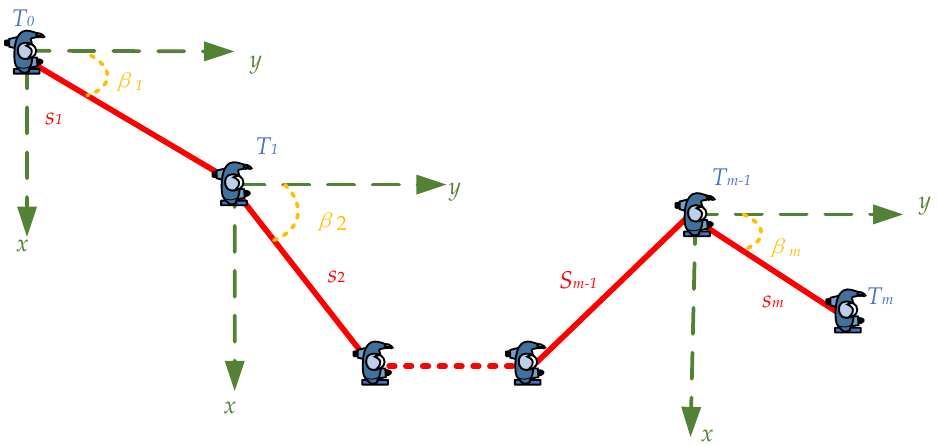
, 𝑖 = 1, 2, 3, … is the trajectory of the target. 𝑖